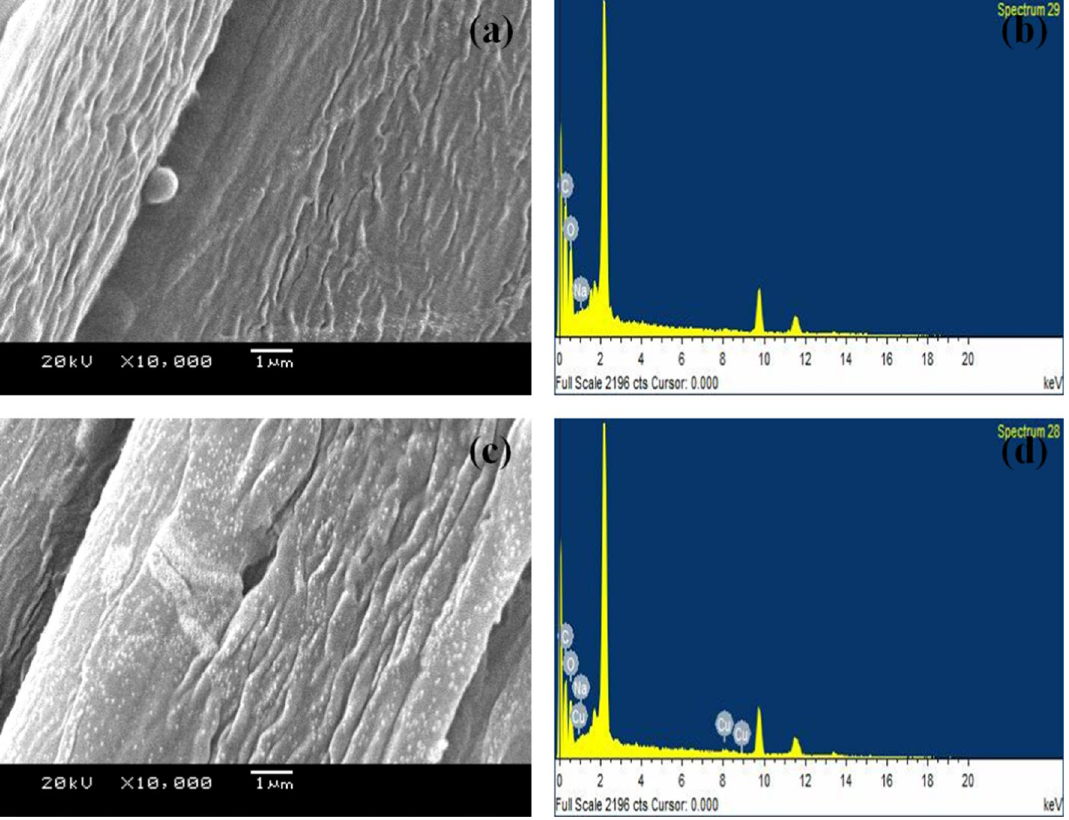
Fig. 2 a SEM image of SCTJF before adsorption; b SEM image of SCTJF after MR dye adsorption; c EDAX image of SCTJF before adsorp- tion; d EDAX image of SCTJF after MR dye